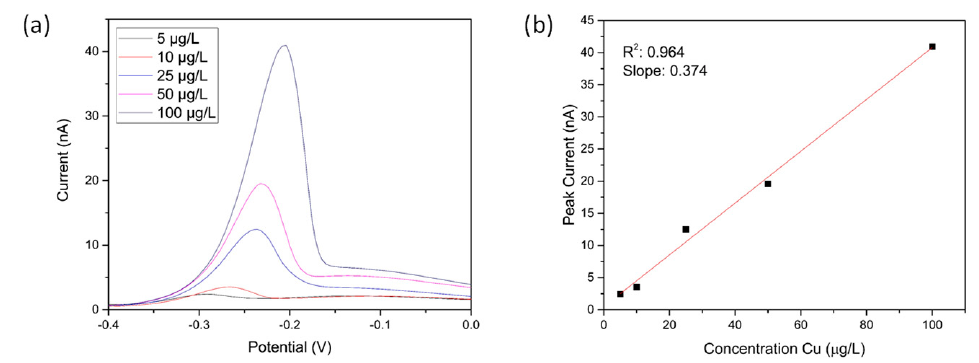
Figure 6. ( a ) Square Wave Voltammograms of Cu solutions at different concentrations (adjusted to pH 2 with acid, deposition for 300 s at − 0.4 V); ( b ) Corresponding calibration line .